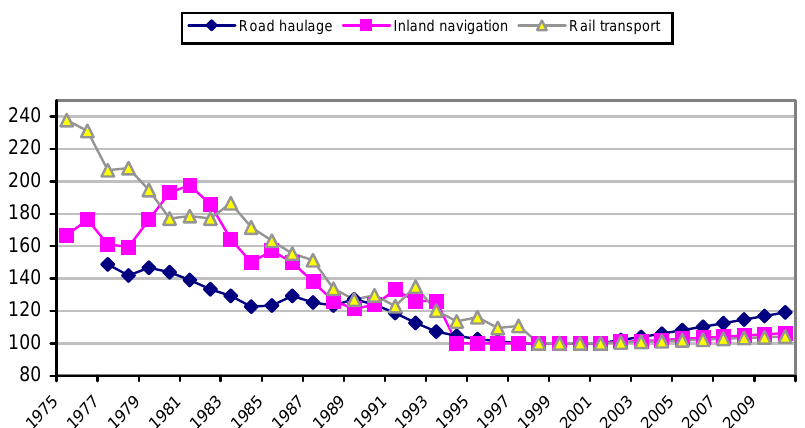
Figure 2. Historical and expected trends in freight rates (continental transport) in indices (2001 = 100). Please note: figures exclude short sea shipping, due to a lack of historical rate